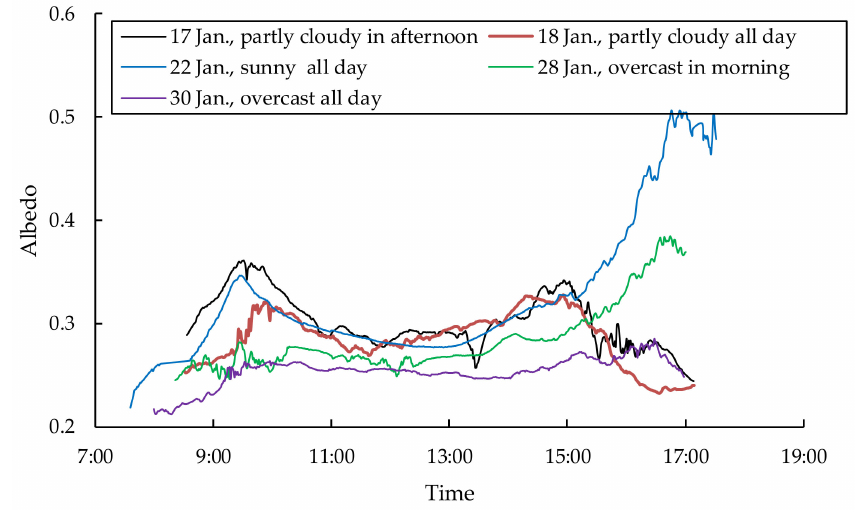
Figure 3. Daily variation of ice albedo under different weather